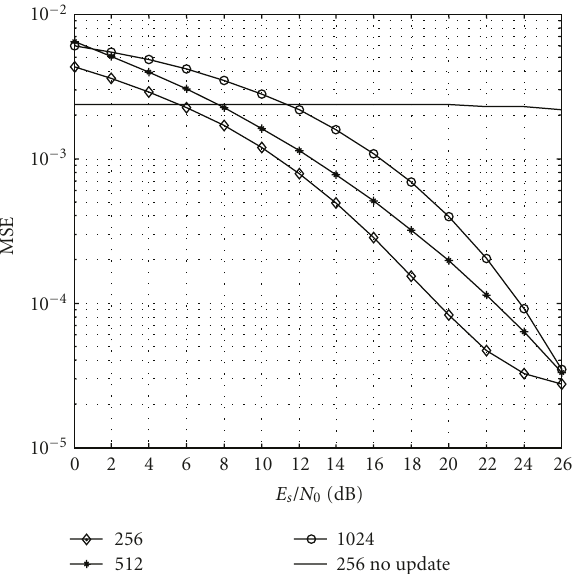
Figure 5: MSE of channel estimation for 180 km/h.